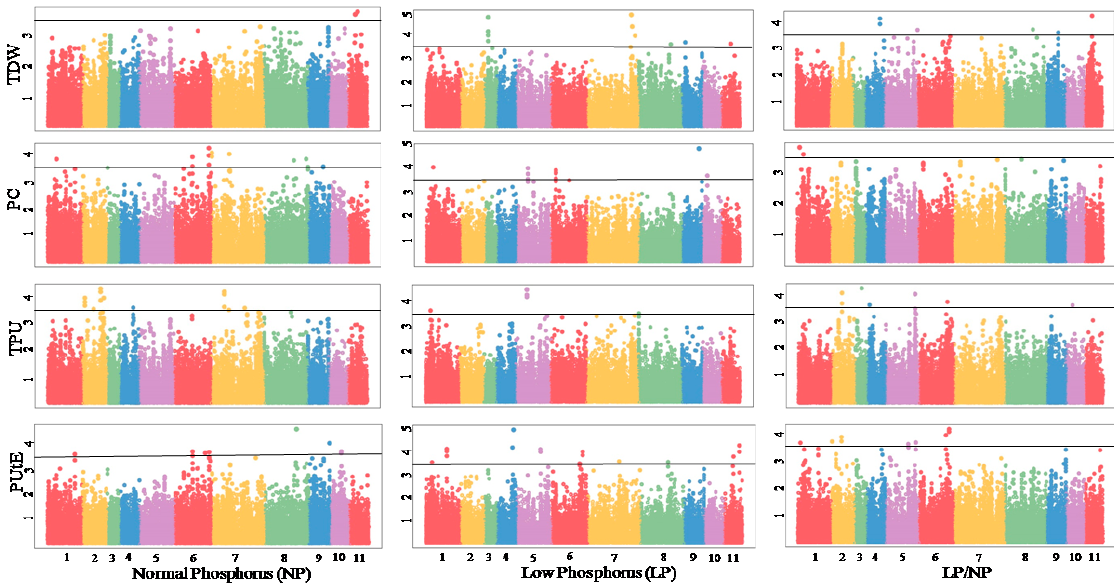
Figure 7. CMLM based Manhattan plots depicting the significant association of SNP markers with total dry weight (TDW), P concentration (PC), total P uptake (TPU) and P utilization efficiency (PUtE) under NP, LP and LP/NP